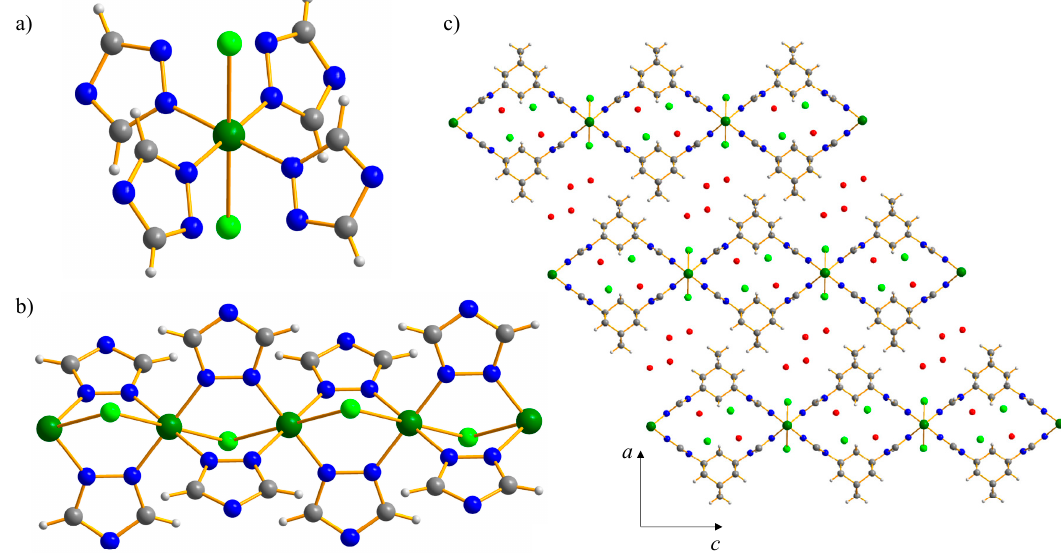
Figure 5. Representation of the crystal structure of {[Cu(tr 2 ad)Cl]Cl · 4H 2 O} n : ( a ) the coordination sphere of the metal ions; ( b ) portion of the 1-D helix; ( c ) portion of the packing, viewed along the [010] crystallographic direction. Horizontal axis, c ; vertical axis, a . For the non-bonding interactions quoted in the text the reader is addressed to Figure S3. Atoms colour code: C, grey; H, light grey; Cl, light green; Cu, green; N, blue; O, red. Main bond distances (Å) and angles ( ◦ ) at the metal ions: Cu–Cl 2.632(7);